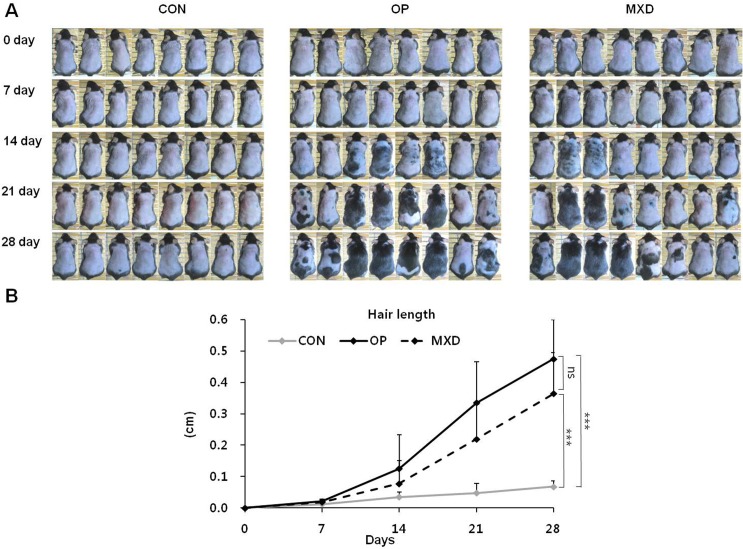
Hair growth-promoting effect of oleuropein in C57BL/6N mice.The back skin of male C57BL/6N mice (eight weeks old) was shaved and treated daily with CON, 0.4 mg OP, or 3 mg MXD for 28 days. (A) The back skin was photographed at 0, 7, 14, 21, and 28 days. (B) The length of randomly plucked hairs was measured at different time intervals (0, 7, 14, 21, and 28 days) after topical application of CON, OP, or MXD. Values are the mean ± SD of eight mice. ns = p > 0.05, *** = p < 0.001 (one-way ANOVA, Tukey's test).